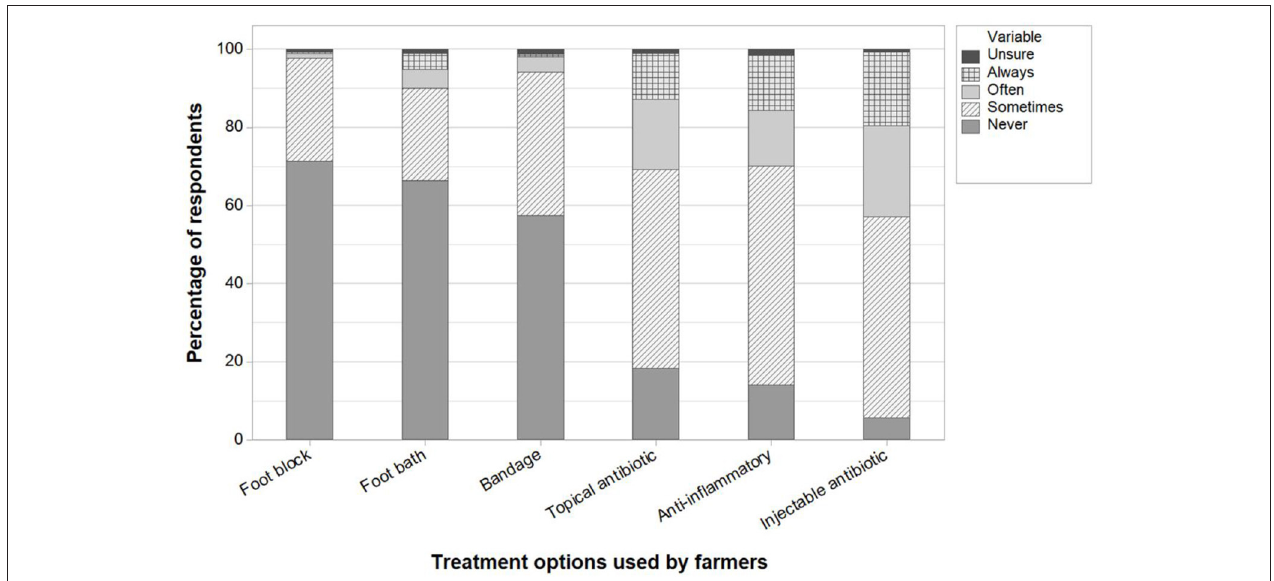
FIGURE 5 | Farmer responses to frequency of use of potential treatment options, as a percentage of respondents (Q5 and Q6, n = 404, 414, 406, 407, 428, and 434, respectively).